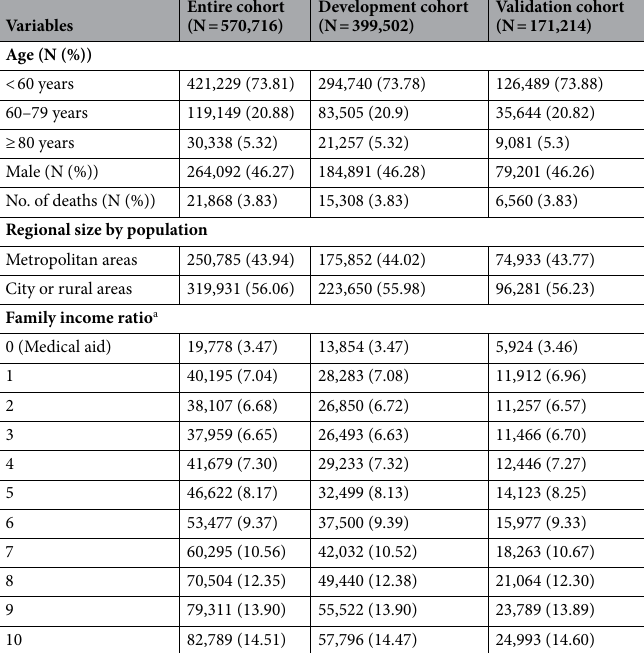
Table 1. Baseline characteristics of the development and validation cohort. a Family income ratio was divided into the following 11 groups: medical aid with group 0 and the income decile with 10 equal -sized groups according to the rank of the gross household income and registered National Health Insurance (based on